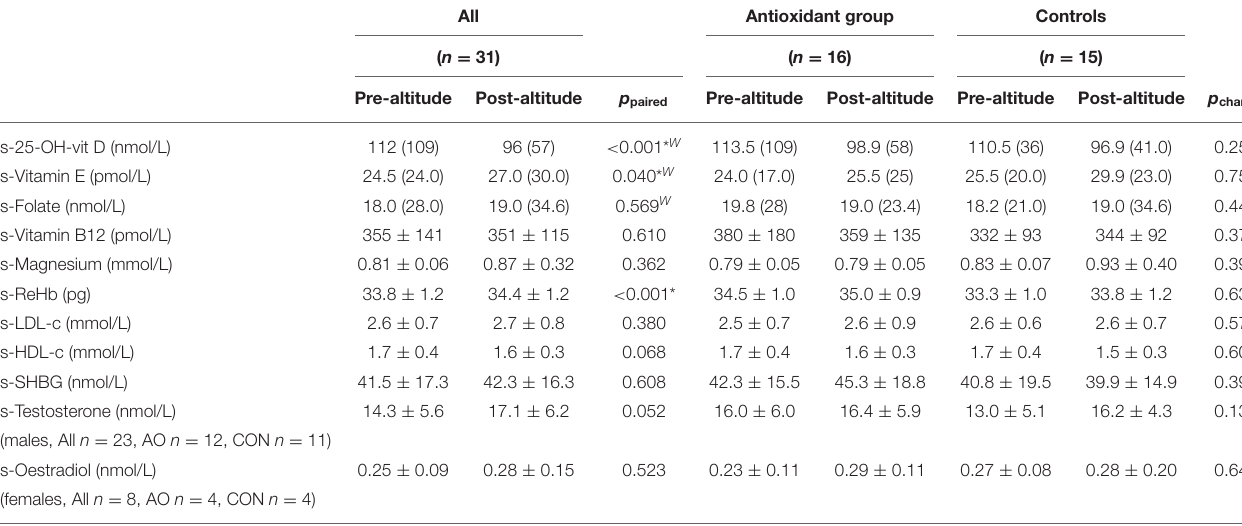
TABLE 5 | Blood parameters before (pre-altitude) and after (post-altitude) the 3-week altitude training camp.